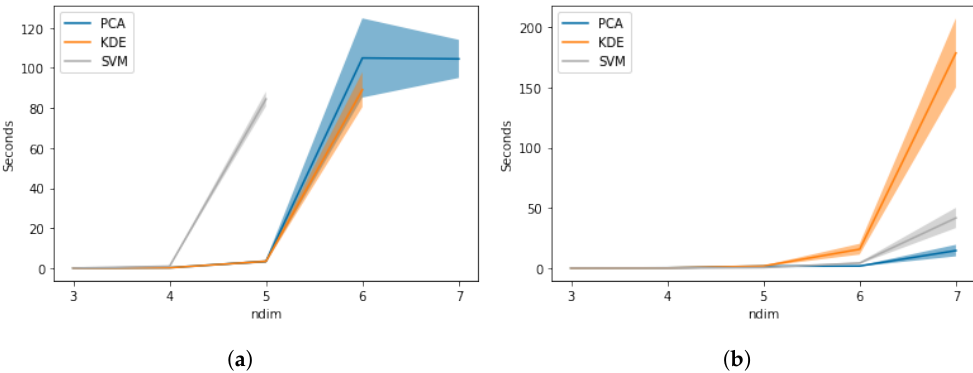
Figure 5. Comparison of computation time in relation to number of dimensions. ( a ) Computation time for TPD outputs. ( b ) Computation time for kernel only.